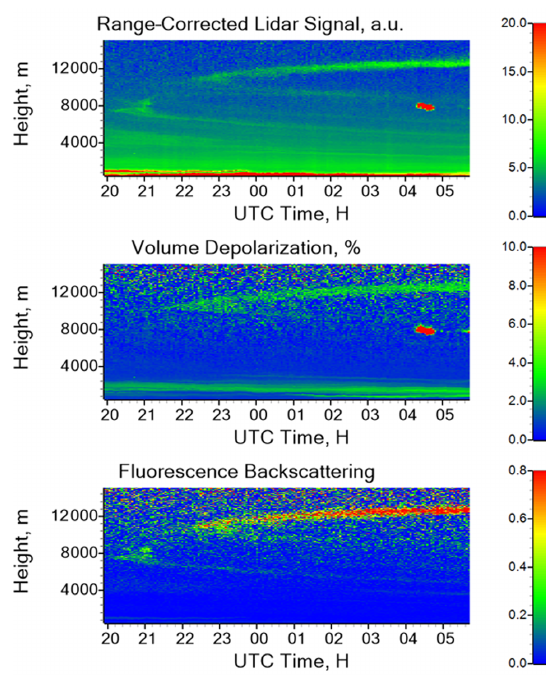
Figure 1. Range-corrected lidar signal at 1064nm, volume depolar- ization ratio at 1064nm and fluorescence backscattering coefficient (in 10 − 4 Mm − 1 sr − 1 ) on 4–5 November 2020.